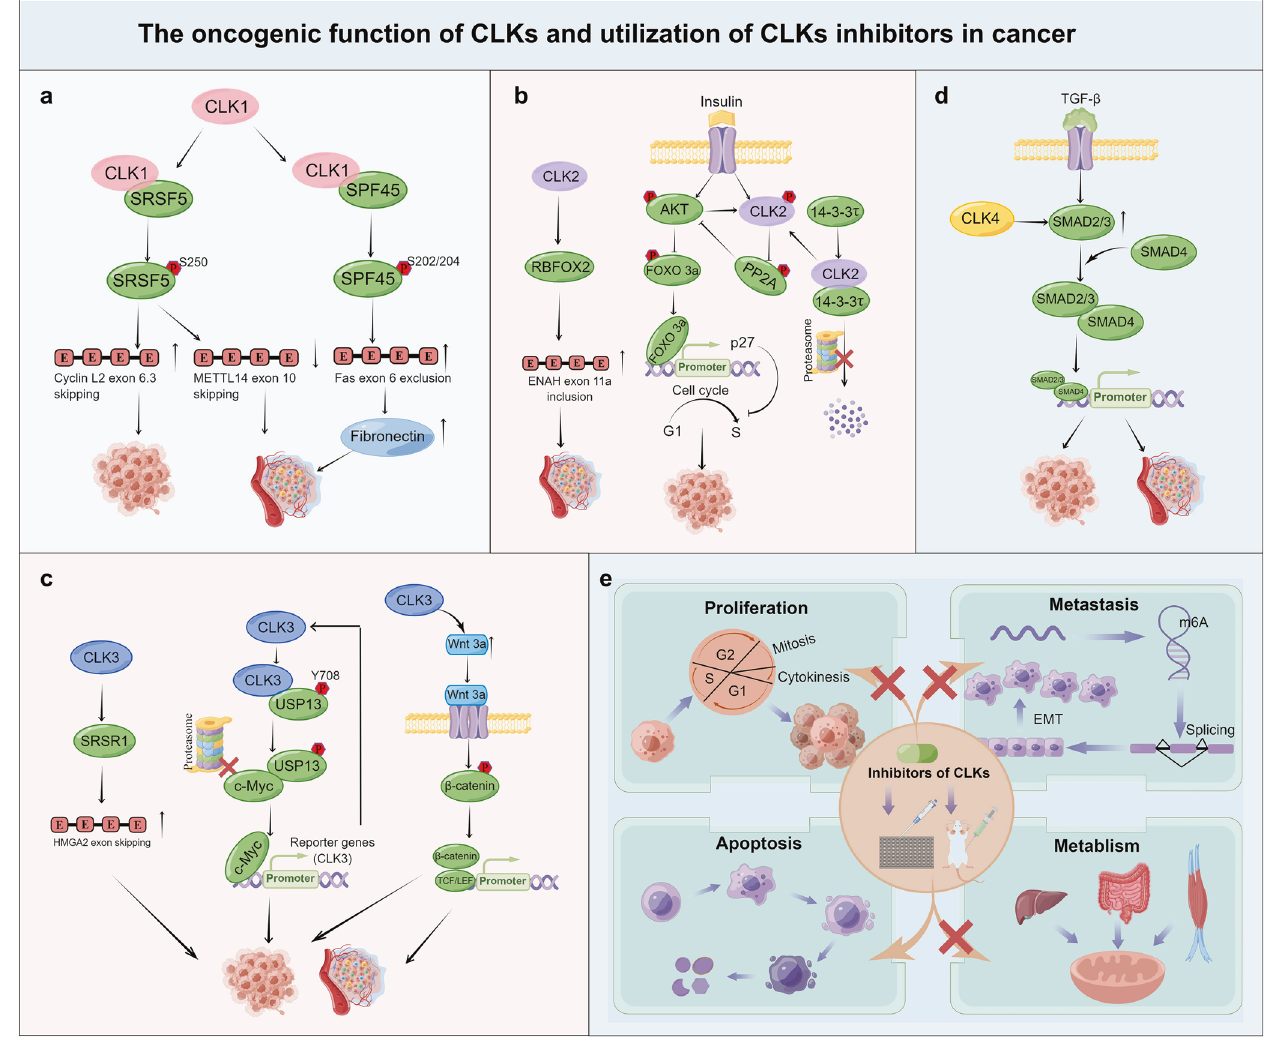
Fig. 6 The oncogenic function of CLKs and utilization of CLKs inhibitors in cancer. a – d CLKs participate in cancer development, invasion, and metastasis by altering mRNA splicing, wnt/ β -catenin signaling, TGF- β signaling, or mediating cell cycle transition. CLKs regulate cancer growth or metastasis by phosphorylating or modulating their downstream regulators, for instance, SRSF5, SPF45, USP13 SMAD3, PP2A, and other proteins. CLKs inhibitors decreased cancer growth, metastasis, metabolism, and promoted apoptosis by modulating genes participating in cell cycle, EMT, metabolic pathway, and apoptosis, respectively. e Preclinical cancer research conducted to assess the therapeutic potential of CLKs-targeting compounds showed signi fi cant tumor growth inhibitory effects. The fi gure was generated by Figdraw(www. fi